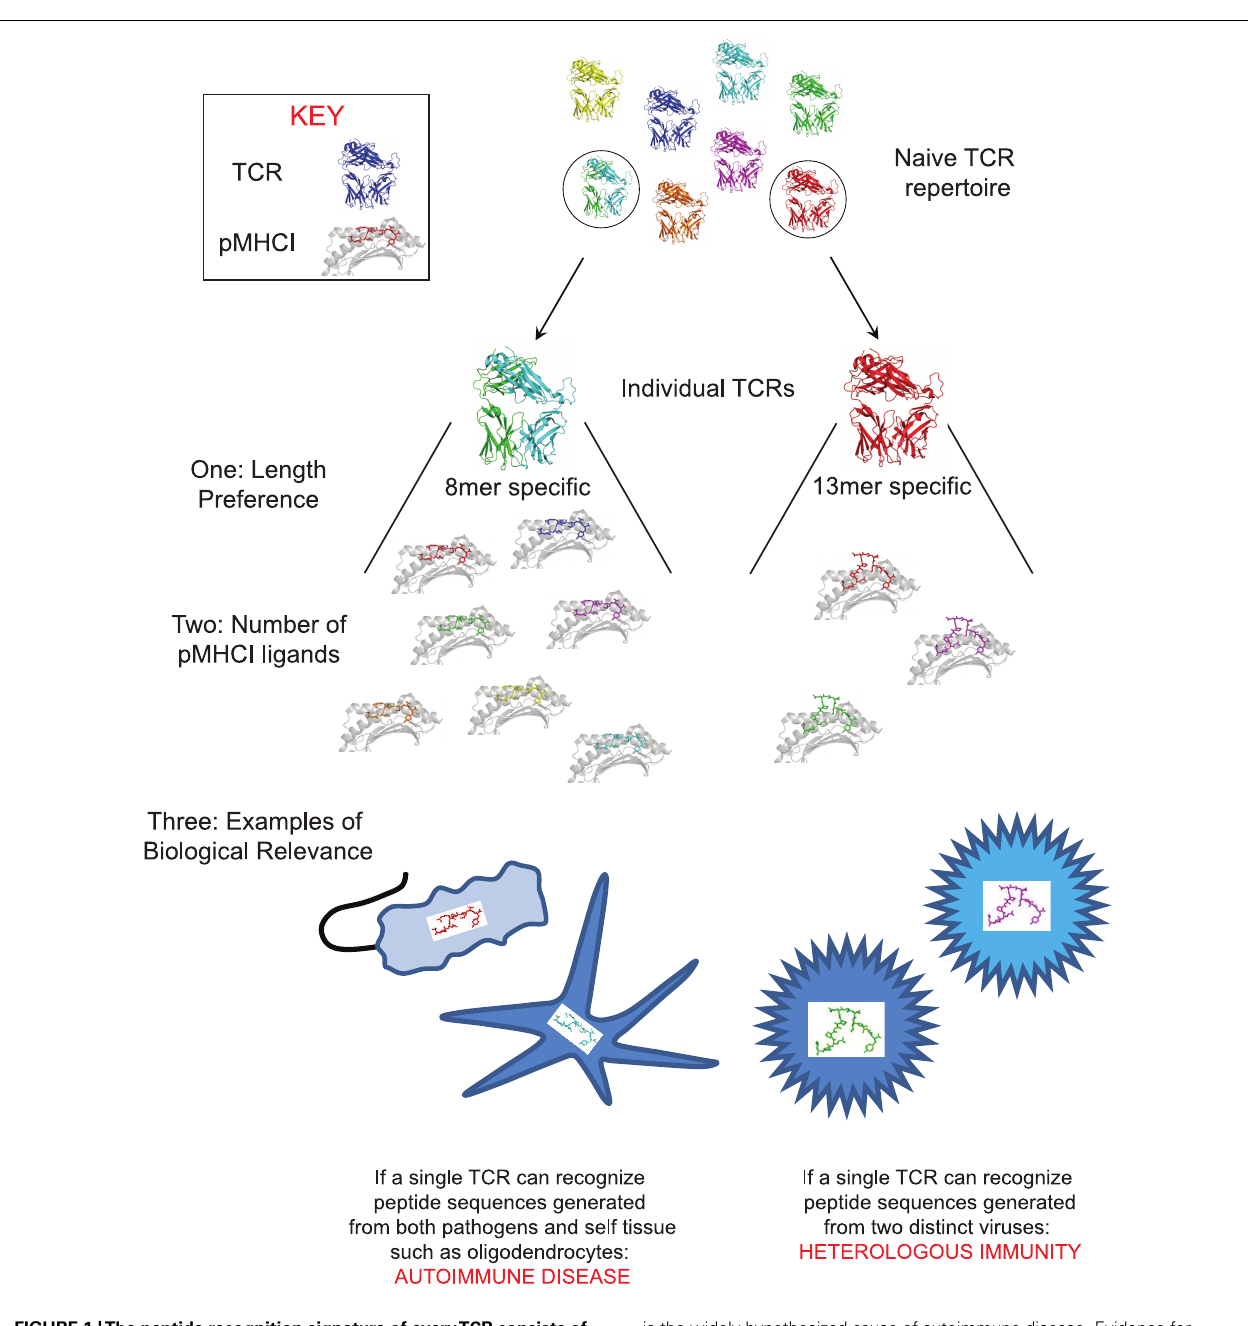
FIGURE 1 |The peptide recognition signature of everyTCR consists of three components .The figure depicts the three components of the peptide recognition signature. One: peptide length preference: this finding implies that effective CD8 + T-cell immunity can only be achieved if “length-matched” antigen-specific CD8 + T-cell clonotypes are mobilized during an immune response, two: number of peptides recognized at the preferred peptide length: which can be very large (up to ∼ 10 6 ).The ability of individualTCRs to recognize multiple pMHCI is essential for the provision of effective immune coverage against the multitude of foreign pMHCI that can be encountered, and; three: sequence of the recognized peptides (which dictates the biological relevance of the peptide recognition signature): the ability to be able to recognize both pathogen and self-derived pMHCI could be the basis for “molecular mimicry,” which